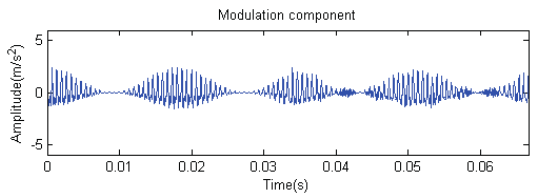
Figure 12. Modulation component.